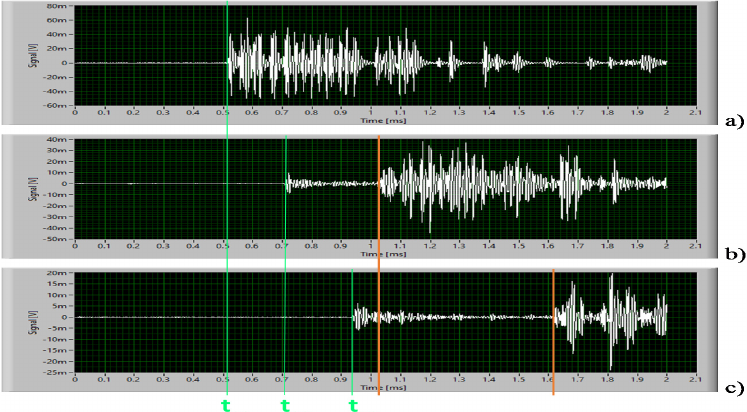
Figure 3. Signals recorded in the measurement channels ( a ) CH2; ( b ) CH3; ( c ) CH5, during the Hsu– Nielsen test performed next to the TR2 sensor after filtering of the signals in the 100–200 kHz frequency band.